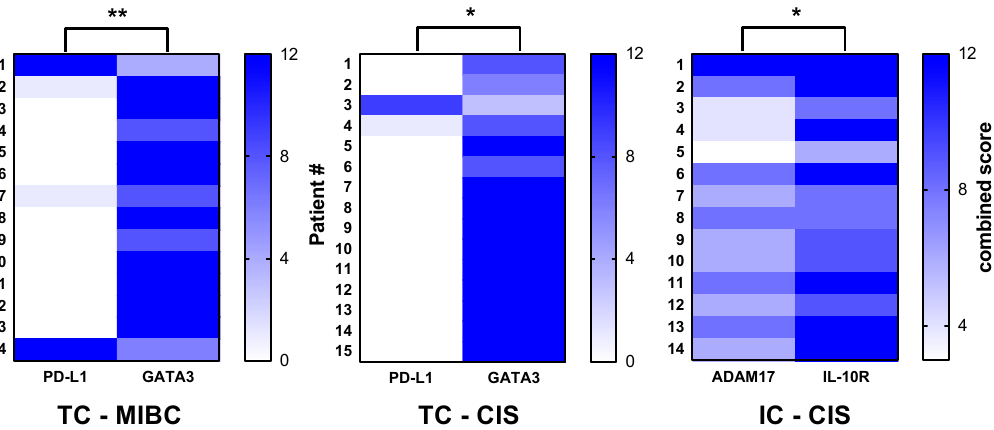
Figure 4. Spearman’s correlation analysis. Negative association between PD-L1 and GATA3 expression in tumor cells (TC) within both tumor regions, and a positive correlation between ADAM17 and IL-10R expression in immune cells (IC) within CIS lesions. * p < 0.05; ** p < 0.01; *** p < 0.001.